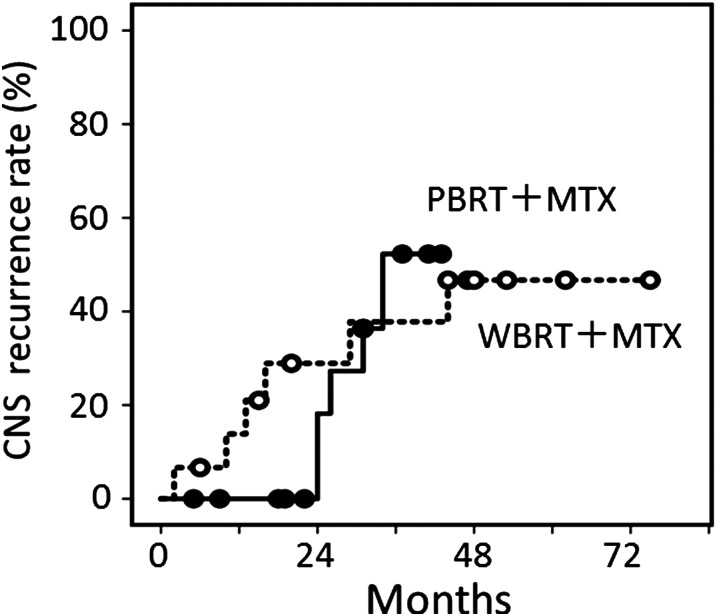
CNS recurrence curves for 16 patients undergoing PBRT plus MTX-based chemotherapy and 15 patients undergoing WBRT plus MTX-based chemotherapy.